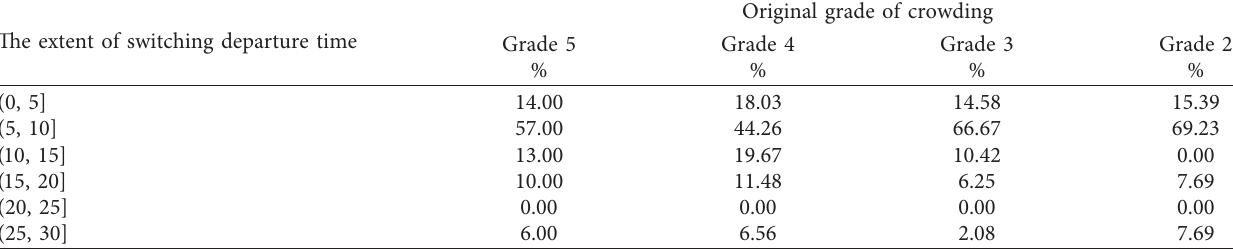
Table 8: The distribution of the extent of switching departure time.